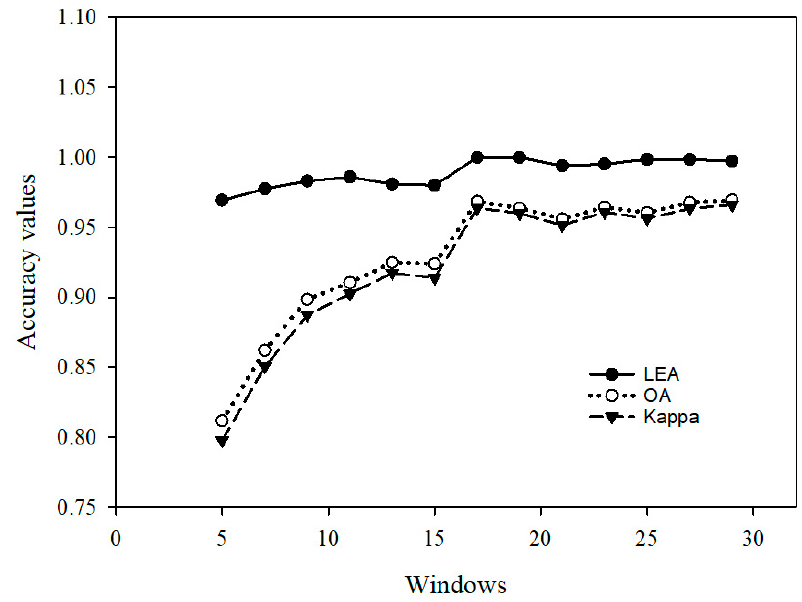
Figure 9. Changes of the classification accuracy using CBAM-P-Net (Spatial First).